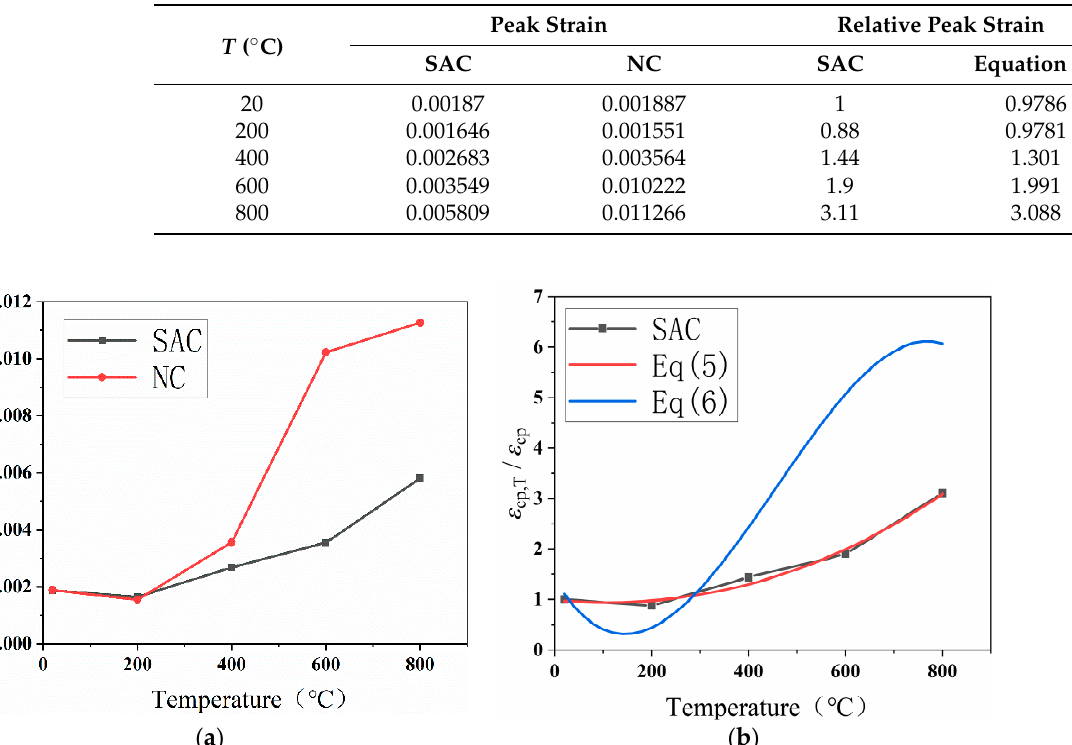
Table 4. Peak strain of specimens after high temperature.